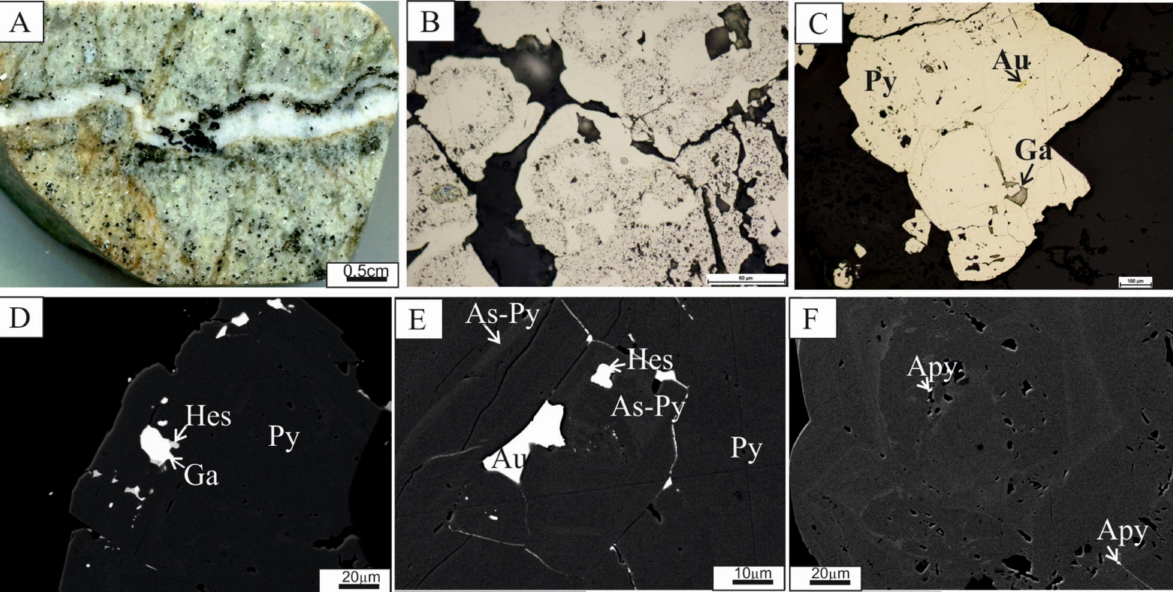
Figure 6. Pyrite-quartz-sericite alteration. ( A ) Metasomatic sulfide-quartz vein with zonal distribution of sulfide inclusions; ( B ) zonal distribution of host rock inclusions in pyrite (Py) metacrystals; ( C ) micro-inclusions of native gold (Au) and galena (Ga) along the boundaries of pyrite crystals; ( D ) linearly distributed micro-inclusions of galena and hessite (Hes) in a pyrite crystal; ( E ) zonal block of arsenic-containing pyrite (As-Py) with inclusions of native gold and hessite; ( F ) the fine-zoning structure of As-pyrite with small arsenopyrite (Apy) inclusions in the more arsenic-rich zones. ( D – F ) Scanning electron microscope (SEM and BSE) images of selected pyrite grains by JSM-5610LV with JED-2300 EMF (Tokyo, Japan), analyst N.V. Trubkin, IGEM